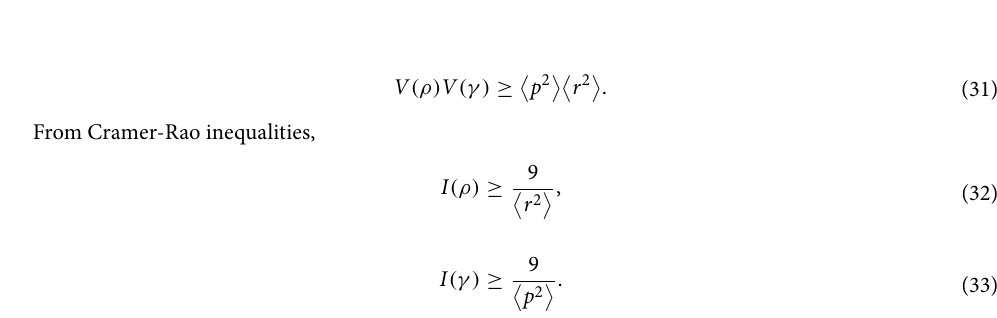
Table 11. Variance in both position space and momentum space for various (cid:31) and C with n = ℓ = 1, D e = 10 and r e = 1.2